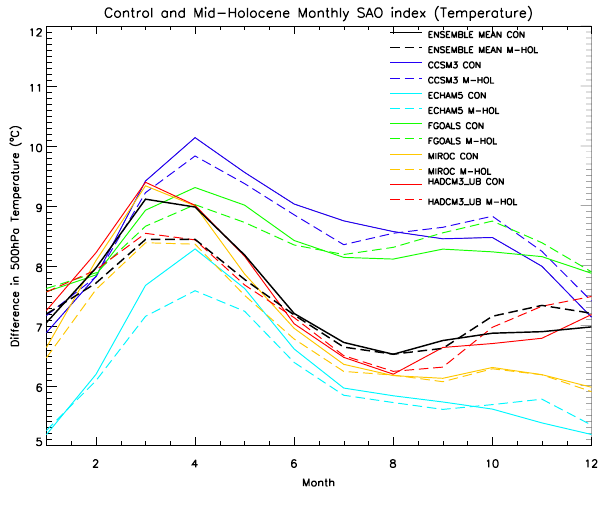
Fig. 6. The SAO index (500hPa 1T ) for all of the available and stable (see Braconnot et al., 2007) models from the PMIP2 control run (solid lines) and Mid-Holocene runs (dashed lines) ( ◦ C). Refer to Table 1 for more details on each